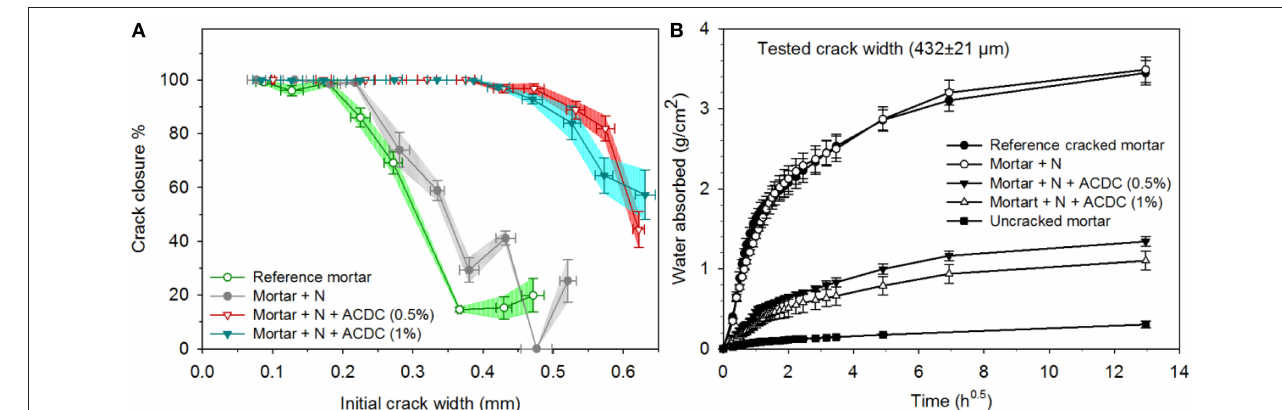
FIGURE 3 | The enhanced self-healing performance of the 28 days old microbial specimens over the control specimens (A) the crack closure performance (horizontal error bars represent the standard deviation, crack widths were grouped with 50 µ m intervals, vertical error bars represent the standard error of the mean, n ≥ 5 ) (B) capillary sorption around the crack zone of the healed specimens [N: Nutrients – 2% Ca(HCOO) 2 + 3% Ca(NO 3 ) 2 ; the error bars represent the standard deviation, n = 3